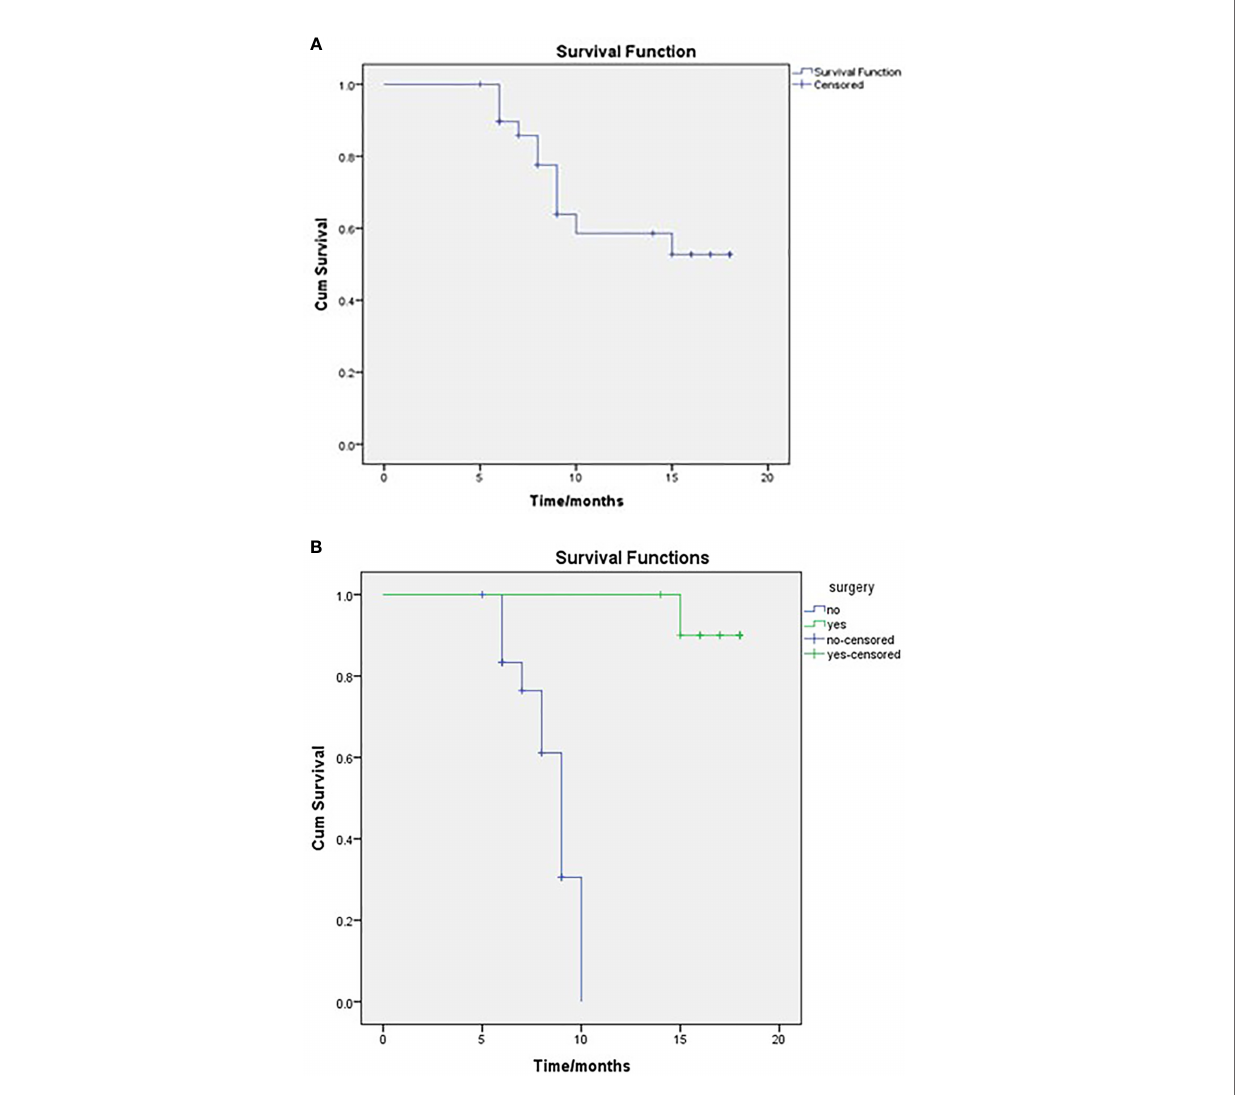
FIGURE 1 | OS of the entire study population (A) and comparison between surgical and non-surgical groups (B) , as regards to the mean OS for the non-surgical cases was 8.51 months and for the surgical cases 17.7 months. Log-rank, P =